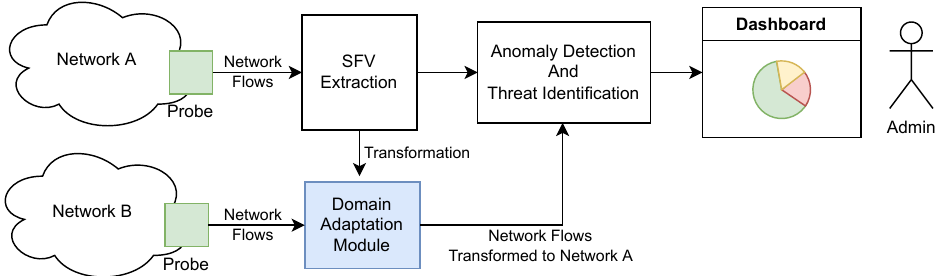
Figure 1. The architecture of the proposed